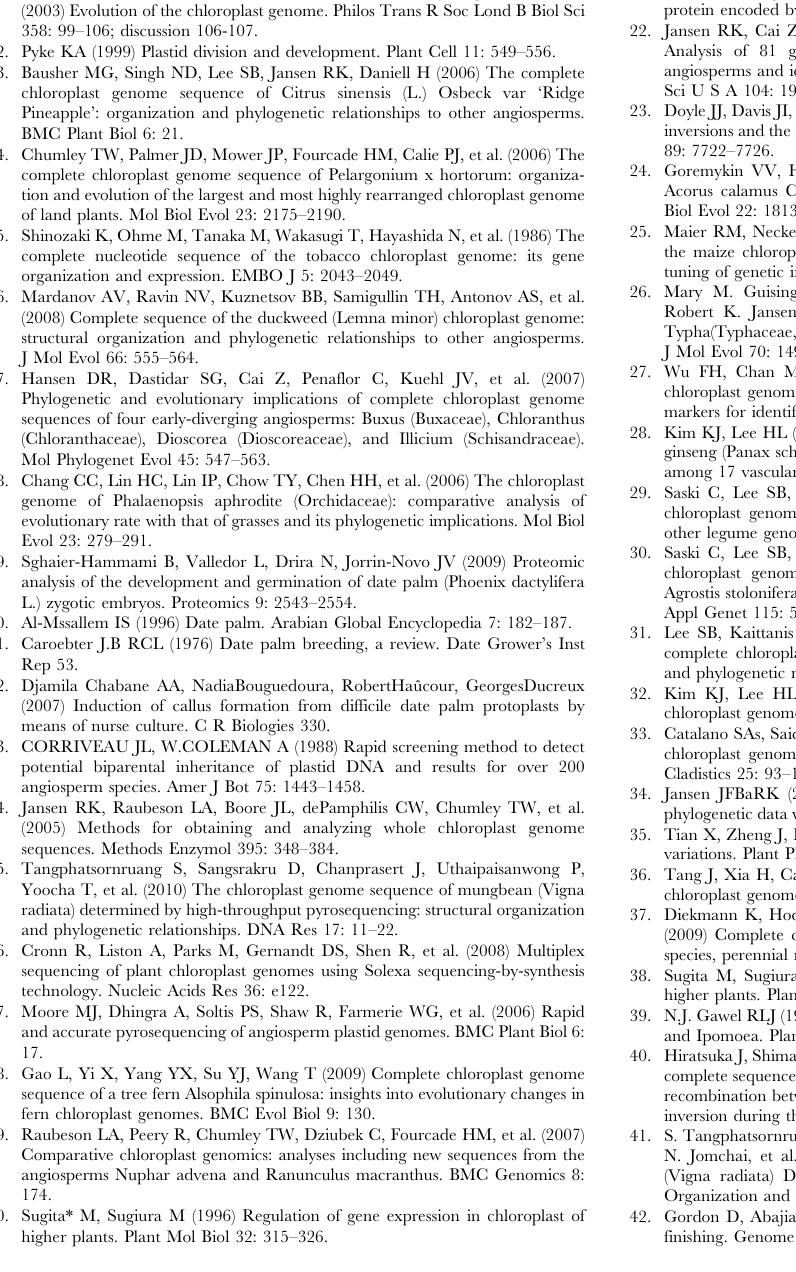
Table S3 The intravarietal SNPs found in non-coding regions Found at: doi:10.1371/journal.pone.0012762.s003 (0.01 MB PDF) Figure S1 Multiple alignments of cemA genes from 77 different cp genomes. Found at: doi:10.1371/journal.pone.0012762.s004 (0.02 MB PDF) Figure S2 Partial 454 transcription reads alignments with date palm cp genome at downstream of atpF and upstream of atpA. Comments are marked with thick blue line and blue color